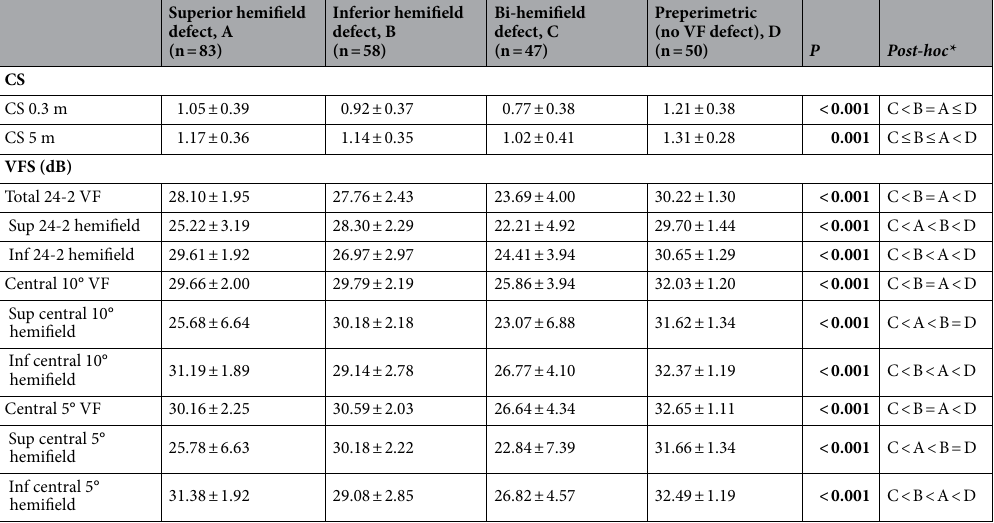
Table 3. Comparison of the contrast sensitivity and visual field sensitivity in the POAG eyes with visual field defects in various hemifields. *Tukey-b’s post-hoc test. Significant values are shown in bold. POAG = primary open-angle glaucoma; CS = contrast sensitivity; VFS = visual field sensitivity; VF = visual field; Sup = superior; Inf = inferior.